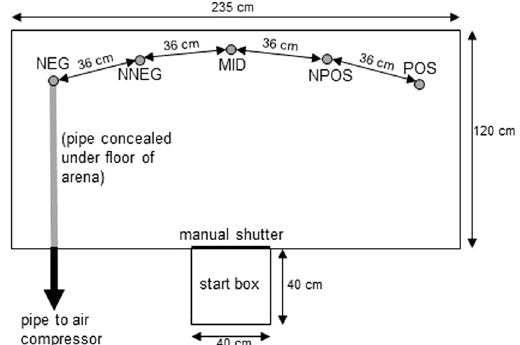
Figure 1. Plan of the arena used for training and testing (not to scale). The circles show the five positions in which cones could be placed during the judgment bias task namely: NEG (negative; punished with an air puff), NNEG (near-negative; ambiguous closest to air puff), MID (middle; ambiguous equidistant from air puff and reward), NPOS (near-positive; ambiguous closest to reward) and POS (positive; rewarded with a mealworm). Note that on a given trial only a single cone was presented. The cones were made from a 3-cm diameter circle of paper cut to the centre and taped into a cone, presented on an 8-cm diameter petri